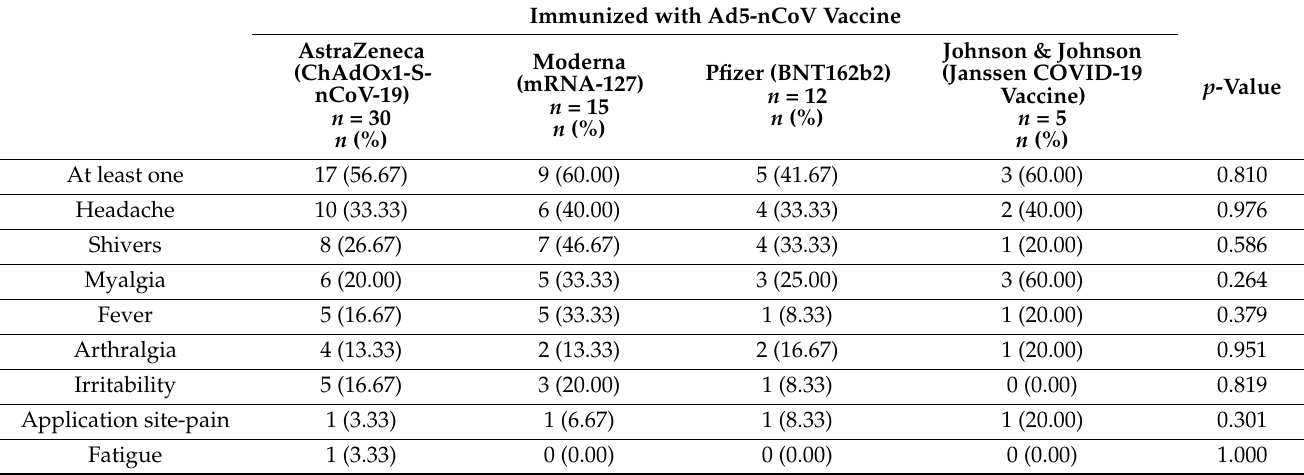
Table 4. Booster vaccine-associated side effects